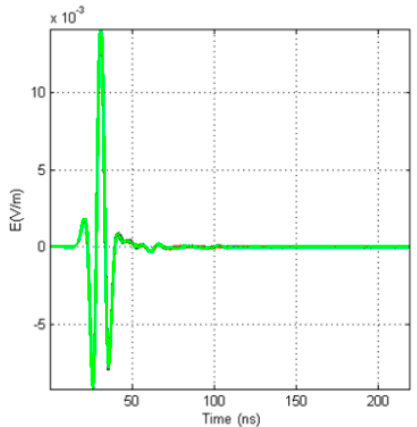
Figure 11. Received signals of four receiving antennas in homogeneous media.